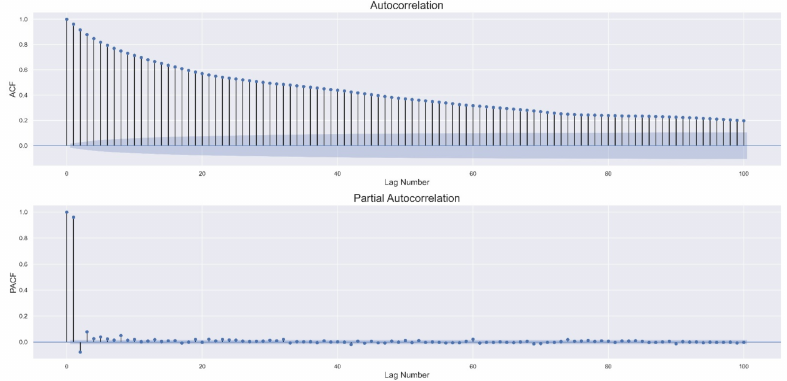
Figure 2. Autocorrelation function (ACF; top ) and partial autocorrelation function (PACF; bottom ) plots for Participant